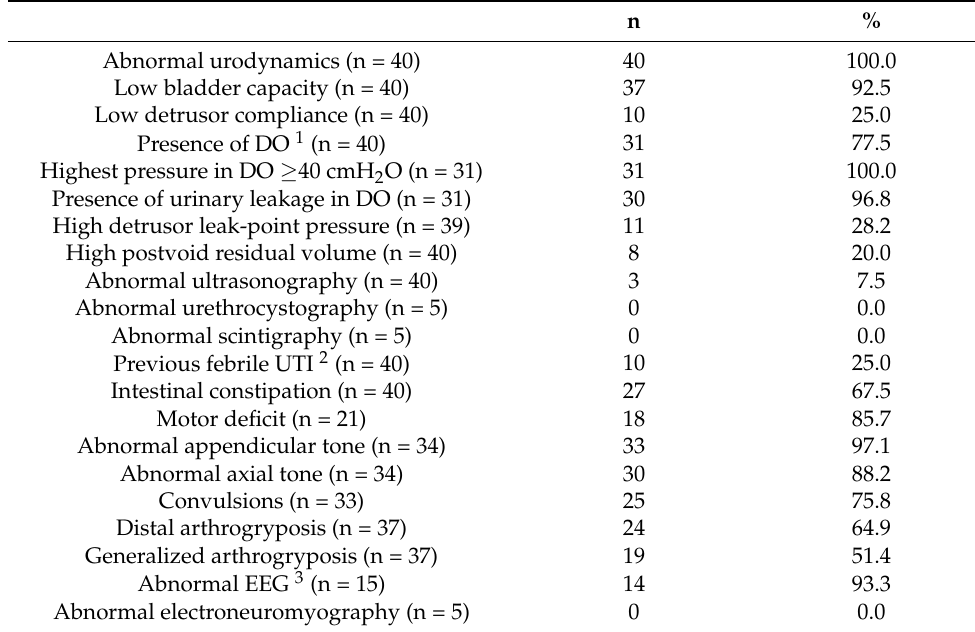
Table 1. General clinical and urodynamic findings of 40 children who underwent UDS at OCUH-UPE from October 2018 to March 2020 as part of the MERG-PC.